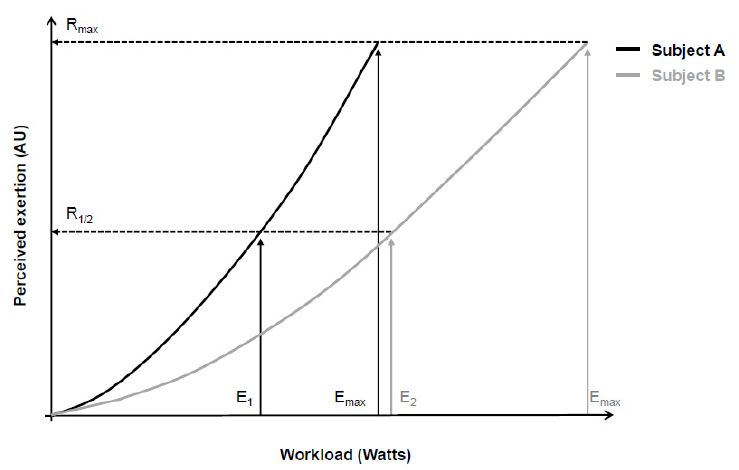
Figure 1. Psychophysical relationship between workload during a cycling exercise (physical stimulus) and perceived exertion (perceptual response) of two subjects (continuous black and gray lines). According to the range model proposed by Gunnar Borg, subjects’ maximum perceptual response (R max ) should be equal, despite between-subjects differences in maximal physical stimulus (E max ). Consequently, different absolute physical stimuli (E 1 and E 2 ) correspond to similar relative perceptual responses (R 1/2 ). Adapted from Marks, Borg, and Ljunggren